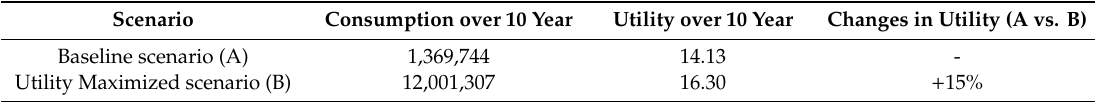
Table 10. Utility of forest owners over 10 years by